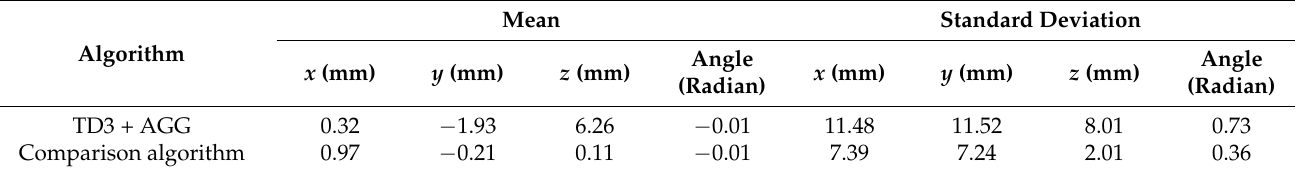
Table 5. Mean and standard deviation of pose errors between end-effector and targets.